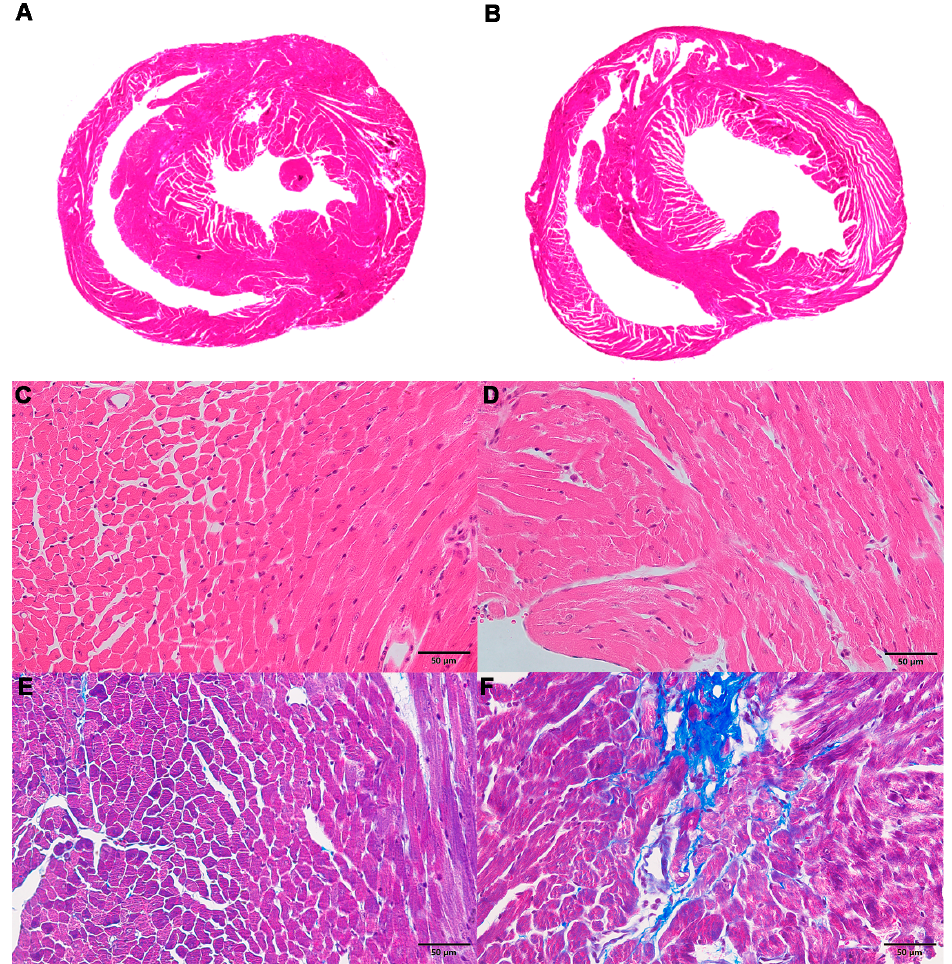
Figure 1. Morphological changes in the myocardium in the control and alcoholic cardiomyopathy (ACM) groups. ( A ) Representative hematoxylin-eosin (H&E) staining for the control group; ( B ) rep- resentative H&E staining for the ACM group; ( C ) representative H&E staining for the control group (400 × ); ( D ) representative H&E staining for the ACM group (400 × ); ( E ) representative Masson’s trichrome staining for the control group (400 × ); ( F ) representative Masson’s trichrome staining for the ACM group (400 ×